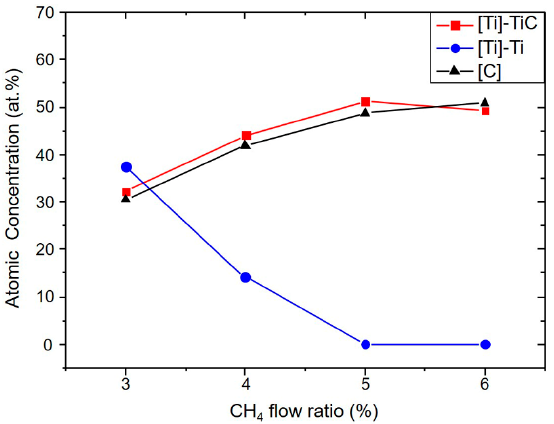
Figure 8. Relative atomic concentration of Ti and C in deposited films as a function of CH 4 flow ratio.